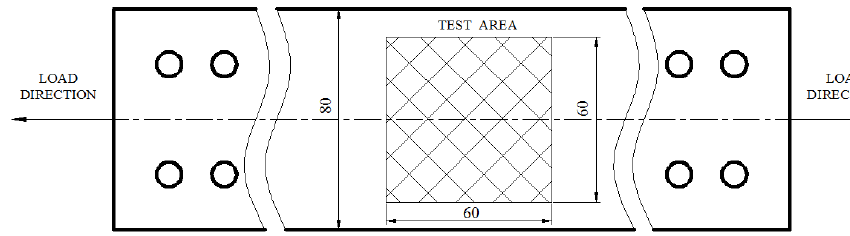
Figure 4. Experimental sample.